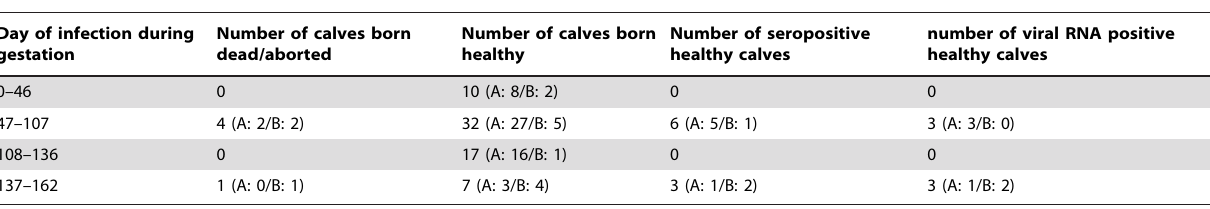
Table 1. Summary of calves borne in both farms in North Rhine-Westphalia,